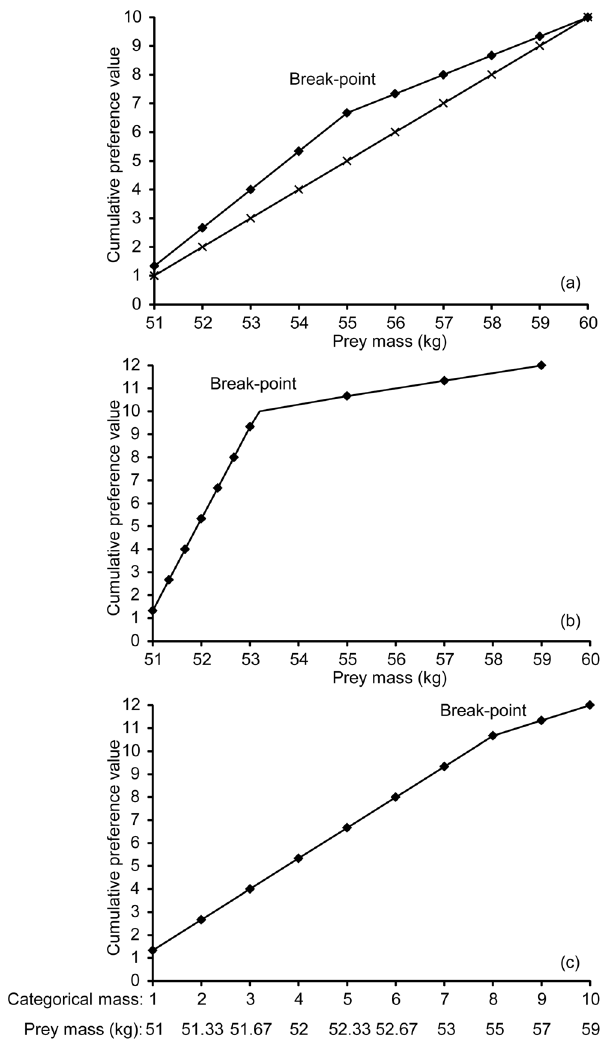
Figure 1. Relationships between prey mass and prey prefer- ence for hypothetical predator-prey communities. In (a) prey masses are evenly distributed and one predator prefers prey of all masses equally (crosses), and another predator prefers prey weighing 51 to 55 kg twice as much as those weighing more than 55 kg (diamonds). In (b) prey masses are not evenly distributed and the predator prefers prey weighing 51 to 55 kg twice as much as those weighing more than 55 kg. In this example the break-point is incorrectly detected at 53.15 kg instead of at 55 kg. In (c) prey masses are represented by categorical values to generate even mass distribution and the predator prefers prey weighing 51 to 55 kg twice as much as those weighing more than 55 kg. In this example the break- point is correctly detected at 55 kg.